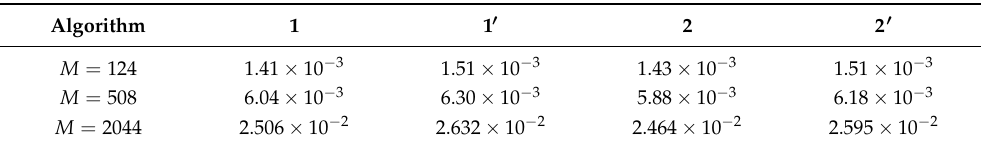
Table 4. Mean execution times (seconds) of 1000 applications of the four algorithms for computing coefficients of a linear combination of T (cid:63)(cid:63) n